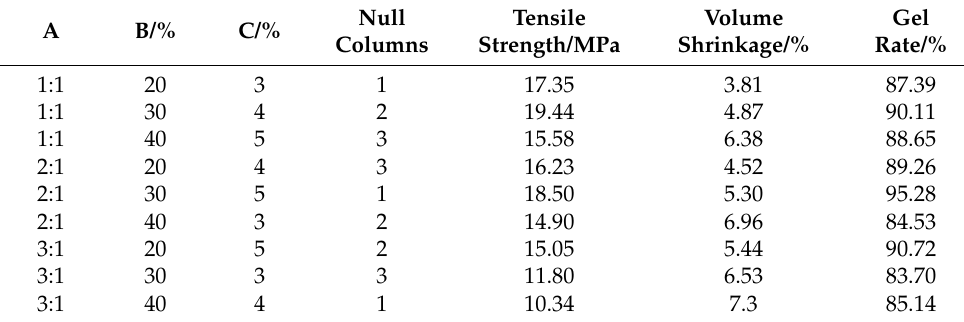
Table 3. Results of the orthogonal experiments.